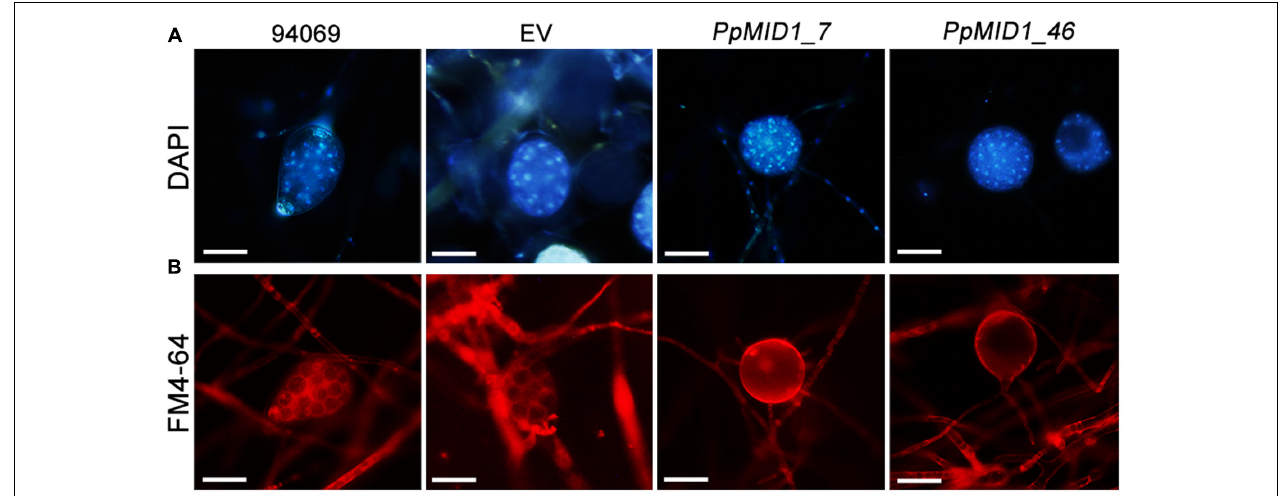
FIGURE 6 | Sporangia of PpMID1- silenced transformants show defective cytoplasmic cleavage. Mycelia blocks of PpMID1_7 and PpMID1_46 , EV, and wild-type Phytophthora parasitica (94069) were incubated in 1% V8 juice medium under light at 25 ◦ C to induce sporangium formation. After 3 days, the sporangia were cold-shocked at 19 ◦ C for 30 min to trigger zoospore differentiation, then stained with: (A) DAPI for nuclear division; (B) lipophilic dye FM 4 – 64 to examine the occurrence of cytoplasmic cleavage. Bar = 20 µ m.